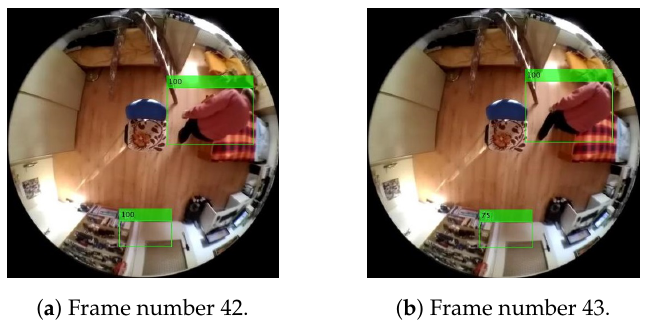
Figure 24. Example of reducing the lifespan at an error finding. The illustration shows the real results of Method 1.1, with a lifespan of 1s, i.e., 4 frames at a frame rate of 4